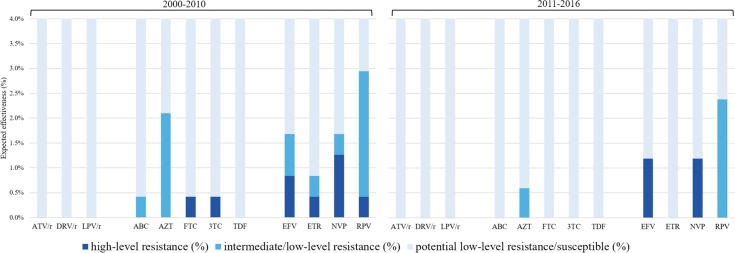
Genotypic sensitivity scores (GSSs) of individual antiretroviral drugs as estimated from sequences obtained from individuals diagnosed with HIV-1 in Slovenia, 2000–2010 and 2011–2016.ATV = atazanavir; r = ritonavir (protease inhibitor booster); DRV = darunavir; LPV = lopinavir; ABC = abacavir; AZT = zidovudine; FTC = emtricitabine; 3TC = lamivudine; TDF = tenofovir; EFV = efavirenz; ETR = etravirine; NVP = nevirapine; RPV = rilpivirine.